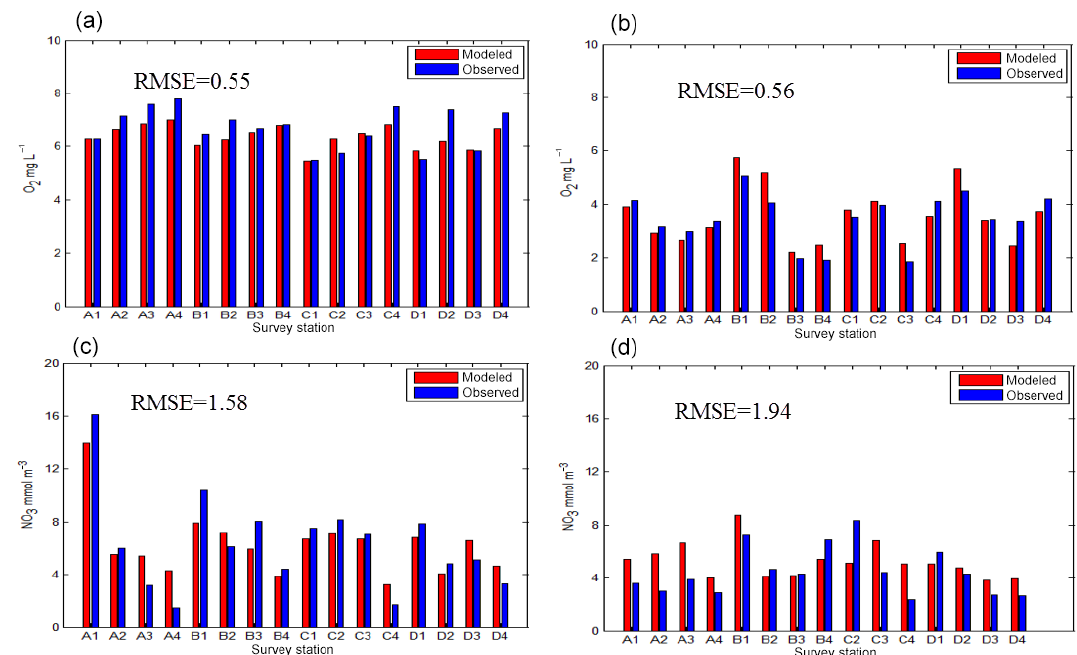
Figure 6. The comparison between modeled results (red bars) and observed data (blue bars) of NO 3 and DO at the stations in August 2011 (see Fig. 1c). (a) Surface DO; (b) bottom DO; (c) surface NO 3 concentration; (d) bottom NO 3 concentration.